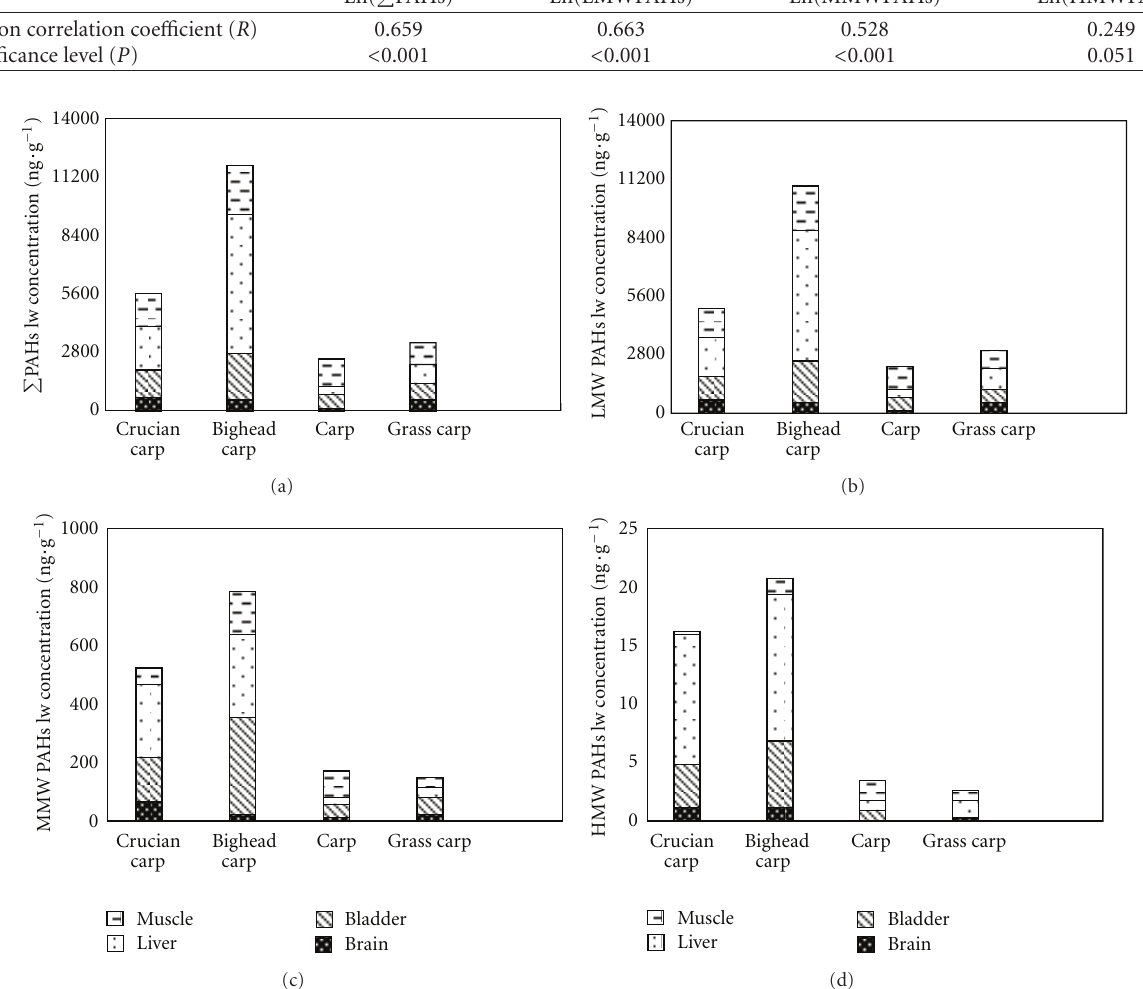
Figure 5: Lipid normalized contents of (a) total PAHs (PAH16), (b) LMW-PAHs, (c) MMW-PAHs, and (d) HMW-PAHs in four fish species. level of PAHs in the specimens we studied. The relation between lipid content and residual level of total PAHs, LMWPAHs, and MMWPAHs was found significant at a 0.01 confidence level. However, the correlation between lipid content and the residual level of HMWPAHs is lower ( R = 0 . 249, P = 0 . 051). In tissues with high lipid content, higher residual levels of PAHs were also found. For instance, lipid content is as high as 22.5% ∼ 35.0% in the brain and 4.6% ∼ 6.8% in the roe, and residual level of PAHs in these tissues was also high (see Figure